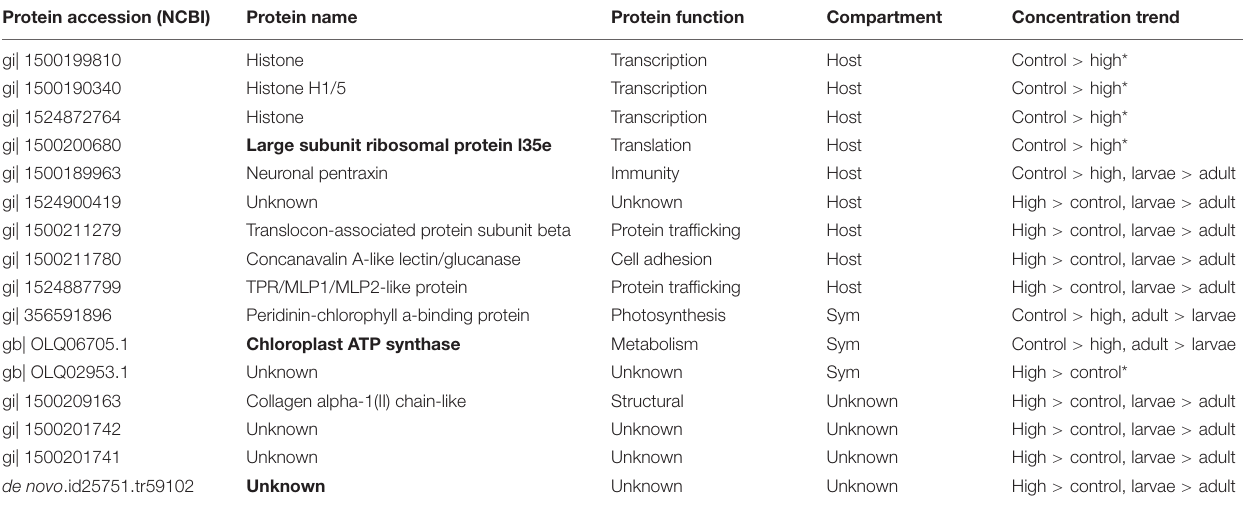
FIGURE 1 | Pocillopora acuta proteomic response to elevated temperature. (A) Compartmental breakdown of the source of all sequenced proteins ( n = 601) compared to (B) differentially concentrated proteins (DCPs) ( n = 74). (C) Venn diagram of DCPs by life stage and temperature and (D) temperature-related DCPs in adult and larval corals. TABLE 1 | Proteins differentially concentrated across temperatures in adult and larval Pocillopora acuta corals. Protein accession